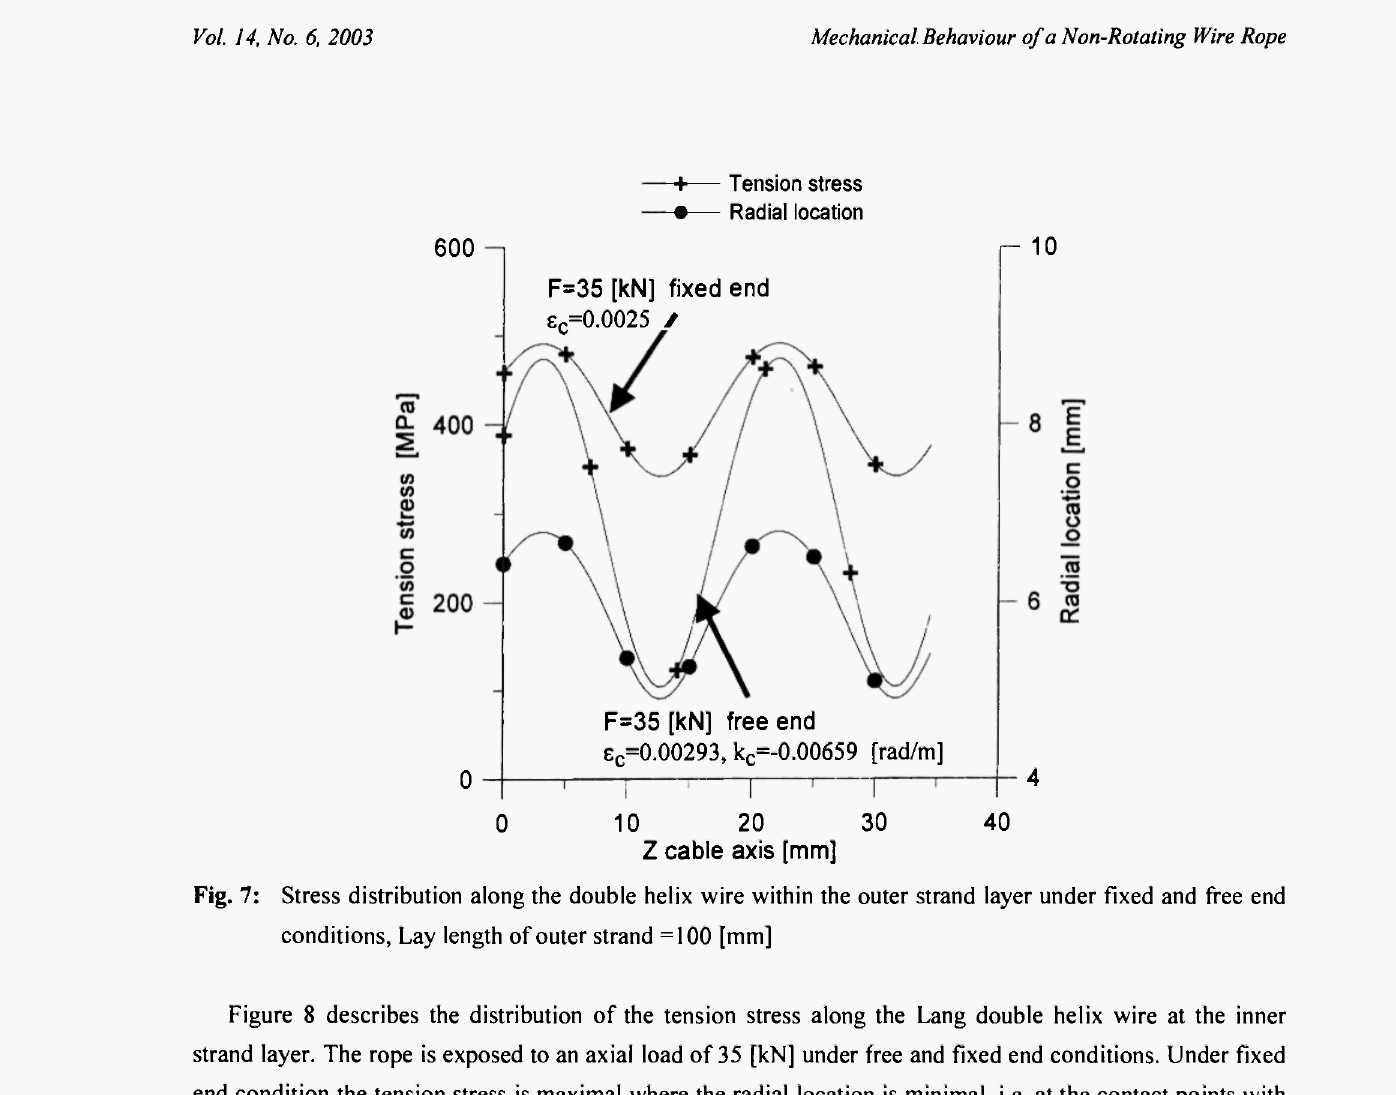
Fig. 7: Stress distribution along the double helix wire within the outer strand layer under fixed and free end conditions, Lay length of outer strand =100